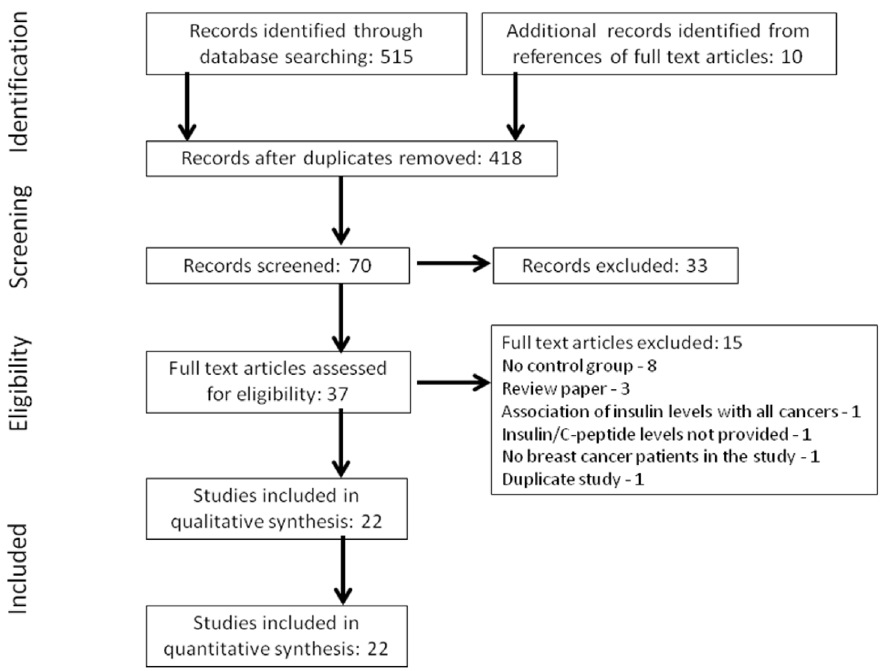
Figure 1. Flowchart of selected studies. Flow diagram showing the number of citations identified, excluded (with reasons for exclusion), and finally included in the meta-analysis.